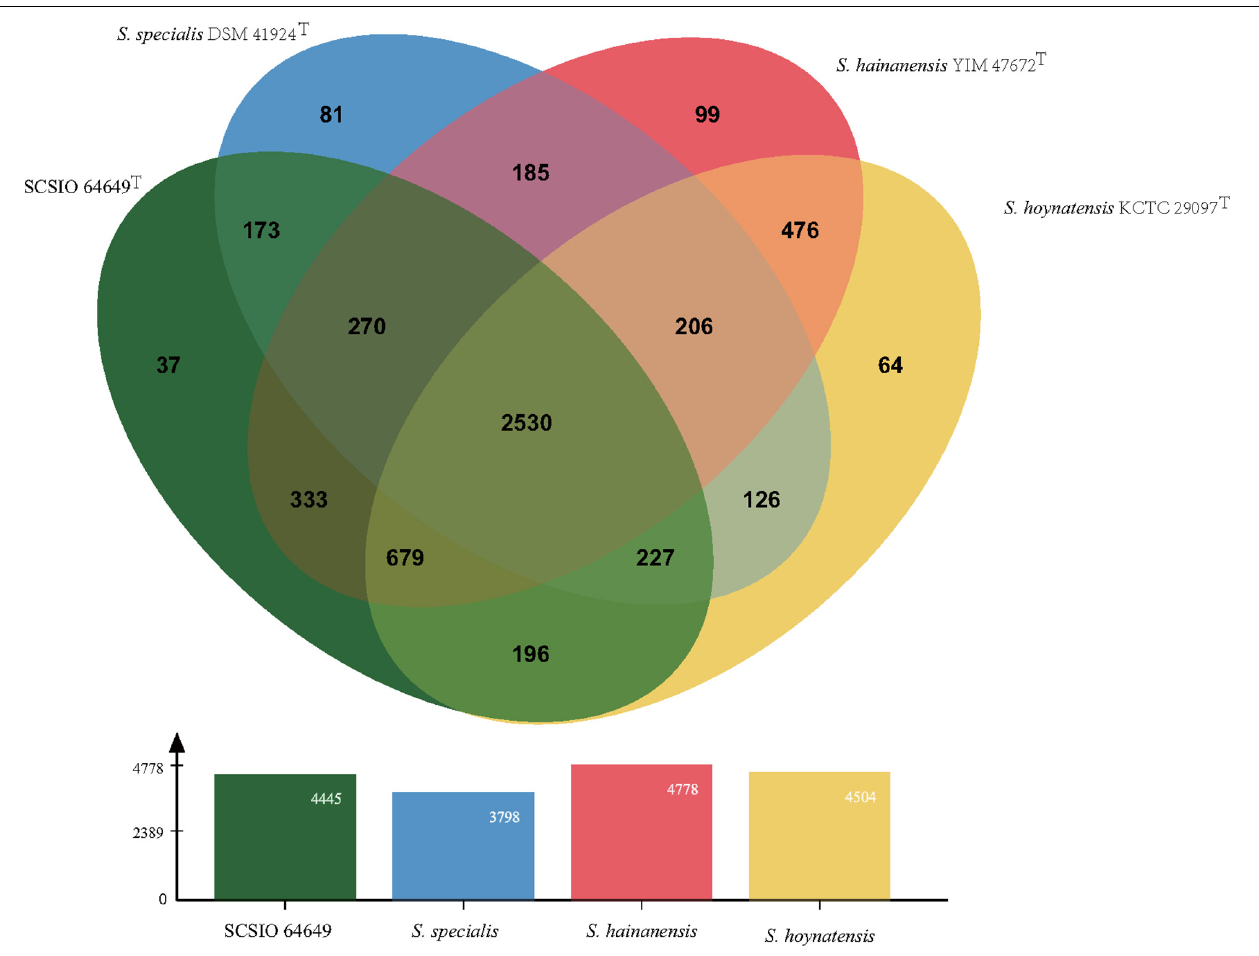
FIGURE 4 | Venn diagram representing the core orthologs and unique genes for strain SCSIO 64649 T and closely related type